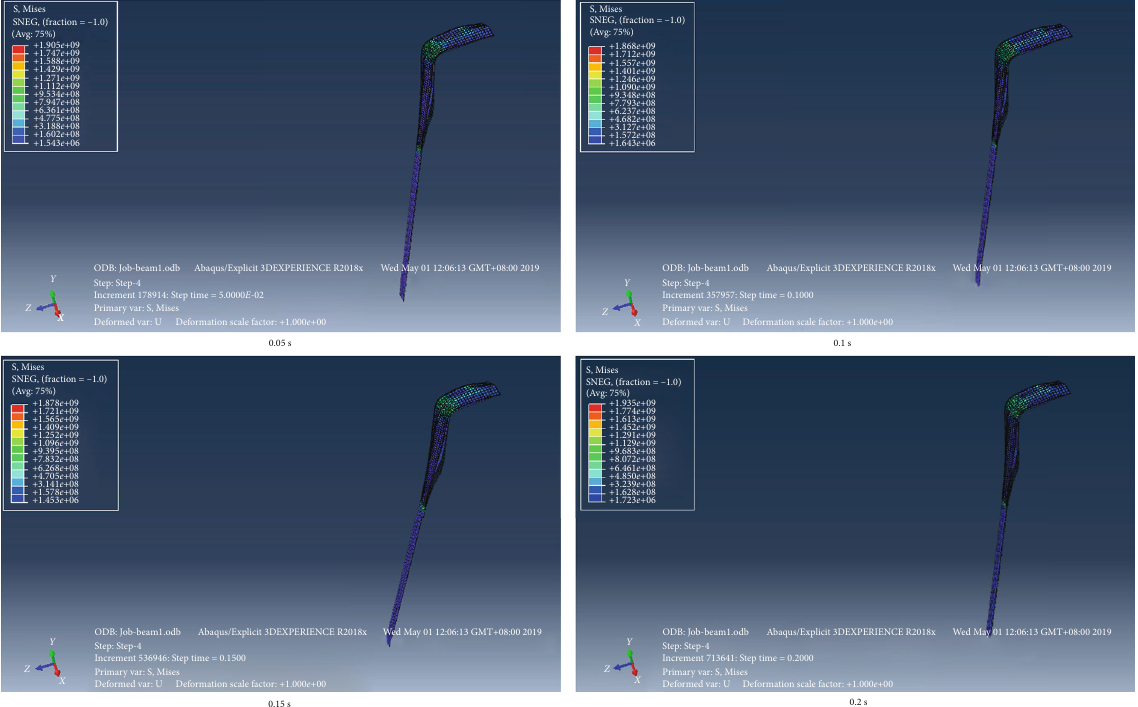
Figure 11: Dynamic behaviors of the lenticular The boundary conditions of the lenticular booms are set, with the right end fi xed and the other end free. To suppress the low-frequency vibration after full deployment, the Rayleigh damping of the beryllium bronze material is set. Figure 7.